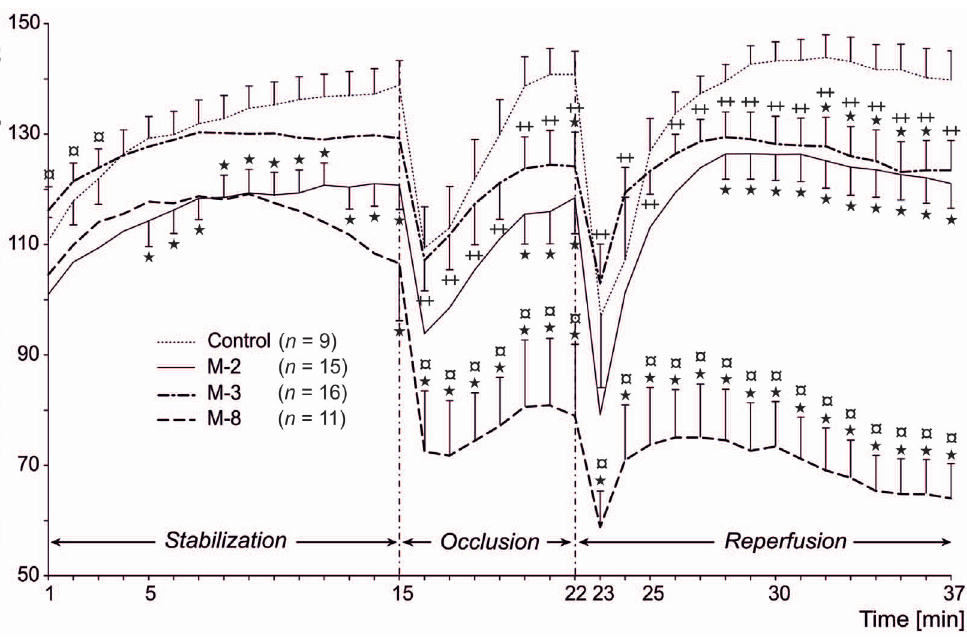
Figure 3. Effects of oral administration (20 mg/kg; 24 + 1 h before occlusion) of the tested three metabolites of furnidipines’ (M-2, M-3, M-8) on mean arterial blood pressure in the rat model for ischemia- and reperfusion-induced arrhythmias. Data are expressed as mean 6 SEM. For sake of simplicity, SEM values are depicted by the vertical lines in the entire trace of control but in the traces of treated groups only when values achieved significance. Values marked with *( P , 0.05) are significantly different from control. Values marked with ¤ ( P , 0.05) are significantly different from M-2 and values marked with ++ ( P , 0.05) are significantly different from M-8. doi:10.1371/journal.pone.0089477.g003 PLOS ONE |